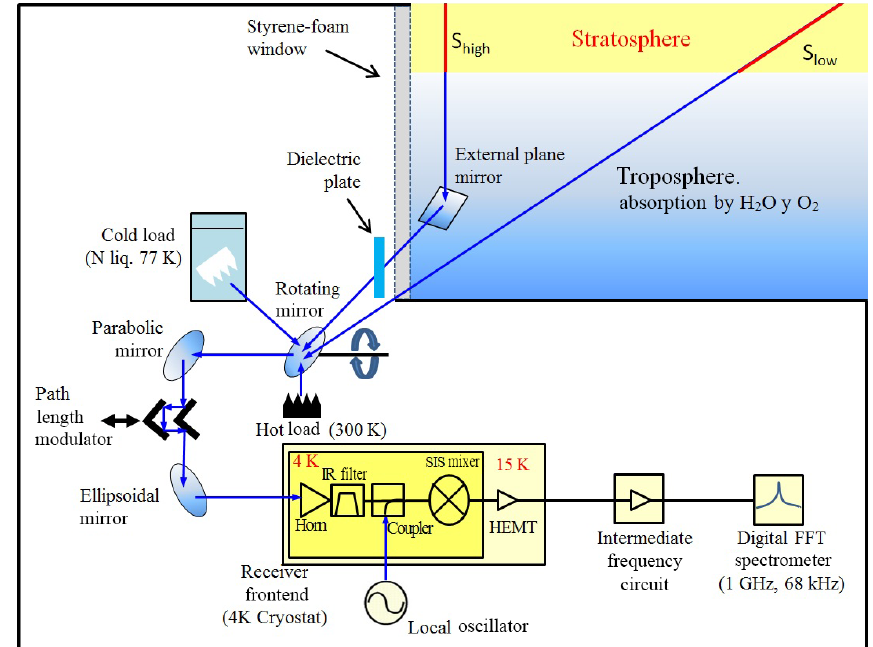
Figure 1. Block diagram of the MWR at the OAPA, Río Gallegos (51.6 ◦ S, 69.3 ◦